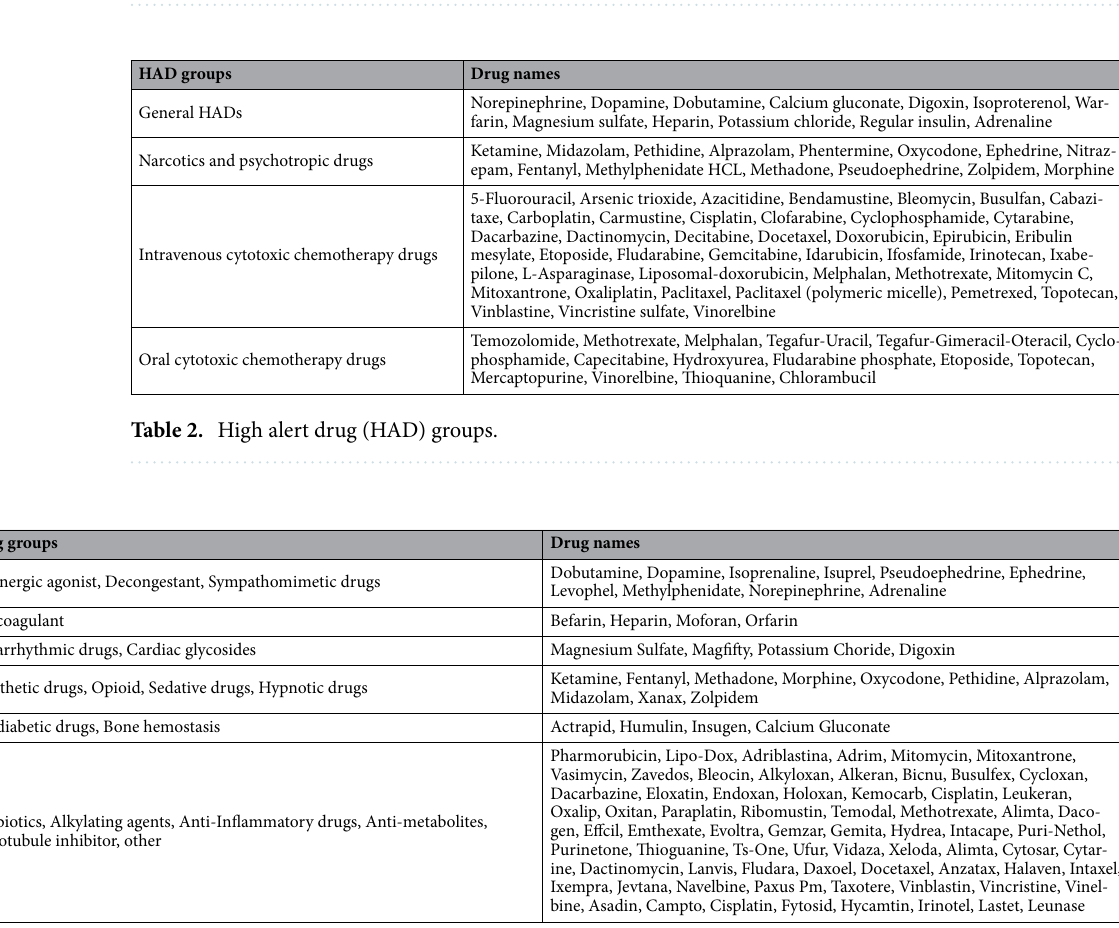
Table 1. Input features and labels of data sets.